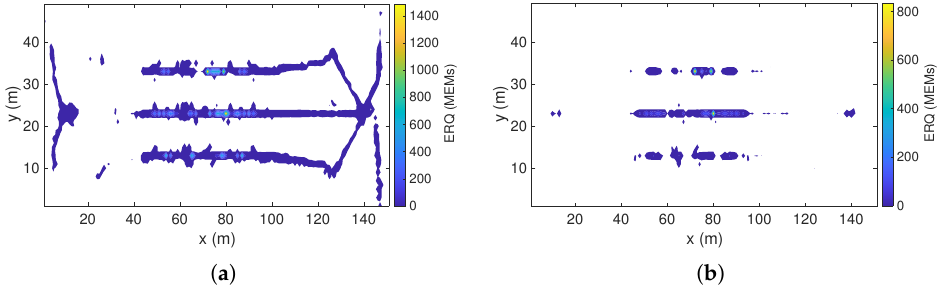
Figure 11. Evaluation of the exposure risk depending on social distancing ( a ) No social distancing (social force = 2); ( b ) Increased social distancing (social force =